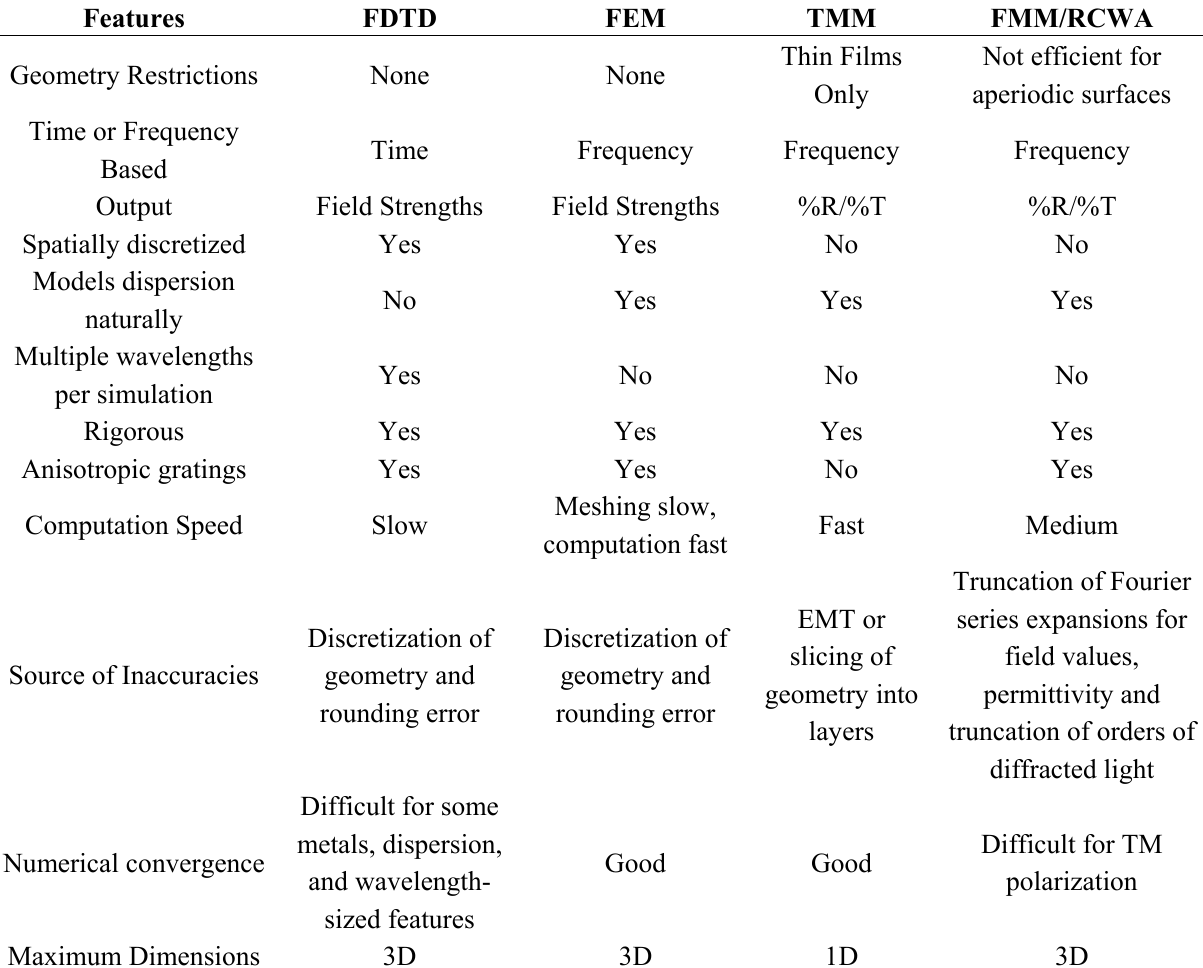
Table 2. Summary of features for the four main modeling methods for